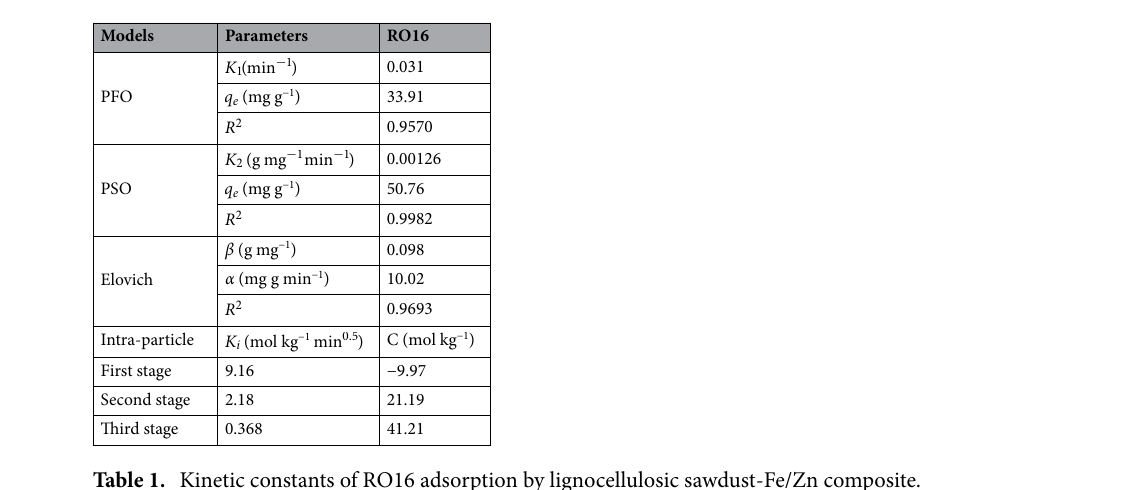
Table 1. Kinetic constants of RO16 adsorption by lignocellulosic sawdust-Fe/Zn composite.